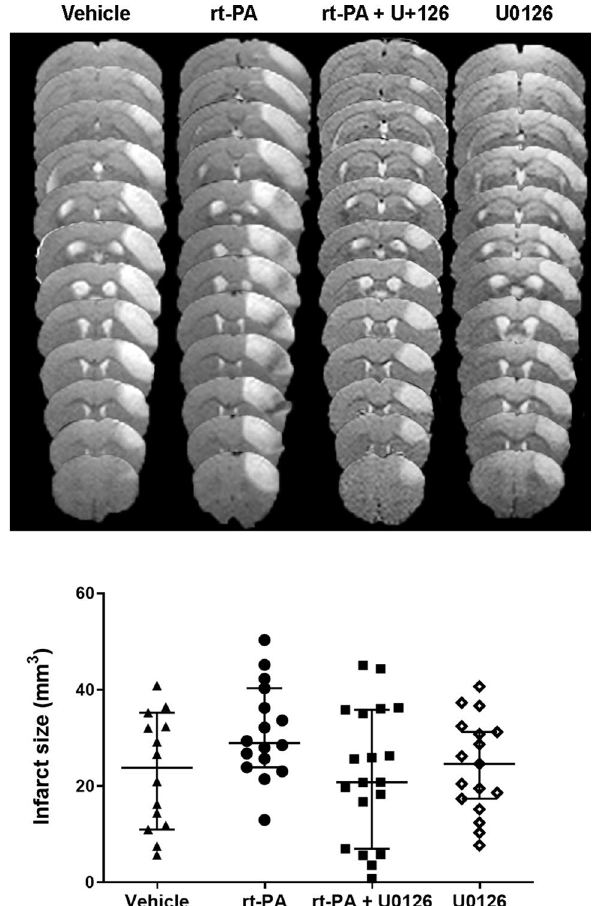
Figure 2. Combination treatment with rt-PA + U0126 did not affect the infarct size after stroke compared to rt-PA and vehicle group. Representative T2-weighted image visualizing the infarct lesion within the cerebral cortex of the different treatment groups. Data are presented as median ± IQR, *P < 0.05 is considered statistically